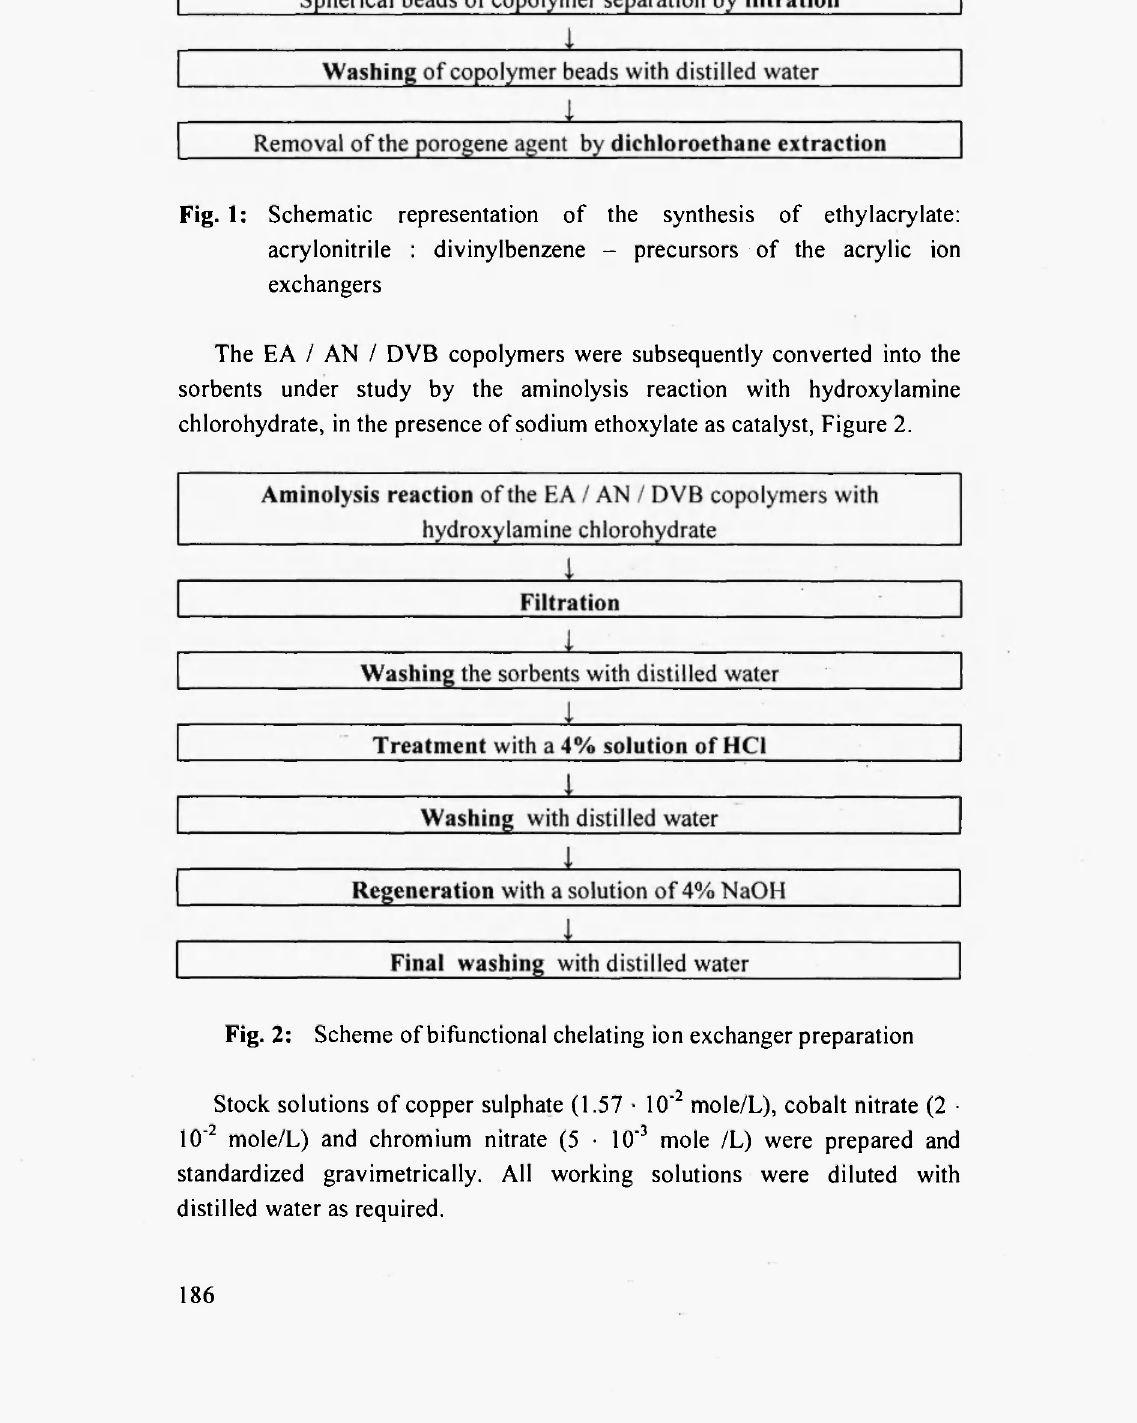
Fig. 2: Scheme of bifunctional chelating ion exchanger